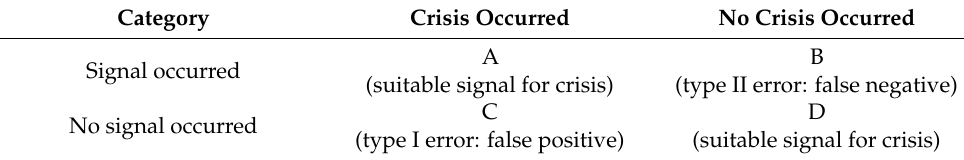
Table 8. Number of cases for the crisis signal